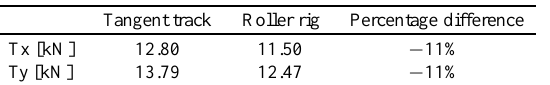
Table 4 Discrepancies between the contact forces yielded by FASTSIM.